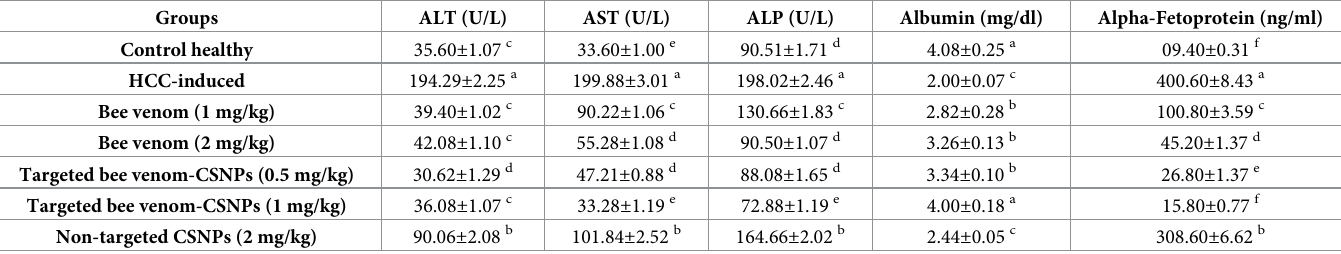
Table 4. Biomarkers f serum liver function in all treated groups of HCC-induced mice.